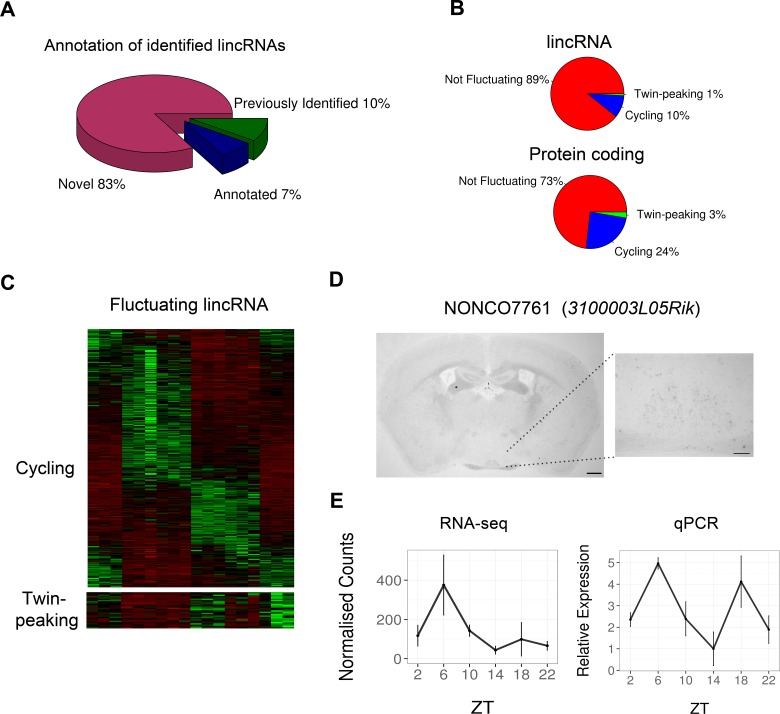
Identification of multiexonic lincRNAs whose expression fluctuates in the suprachiasmatic nucleus (SCN).(A) Proportion of the 3187 identified lincRNAs which (i) have been previously annotated (according to Ensembl or UCSC), (ii) are not annotated in these resources but have been identified in other studies (Belgard et al., 2011, Ramos et al., 2013) or (iii) are unique to this study. (B) Proportion of the 3187 identified lincRNAs which show significant fluctuating expression patterns (twin-peaking module and DESeq2 q < 0.05, or JTK cycle q < 0.05 and DESeq2 q < 0.05); protein-coding genes are shown for comparison. (C) Heatmap showing the expression levels in each biological replicate for the 341 fluctuating lincRNAs. (D) In situ hybridisation (ISH) of NONCO7761 (3100003L05Rik) at ZT6 in the mouse brain showing low yet distinct expression in the SCN. Scale bar: 0.5 mm (low magnification), 0.2 mm (high magnification). (E) RNA-seq and quantitative polymerase chain reaction (qPCR) show fluctuating mean expression ± SD of the lincRNA NONCO7761 (3100003L05Rik) over 24 hr.